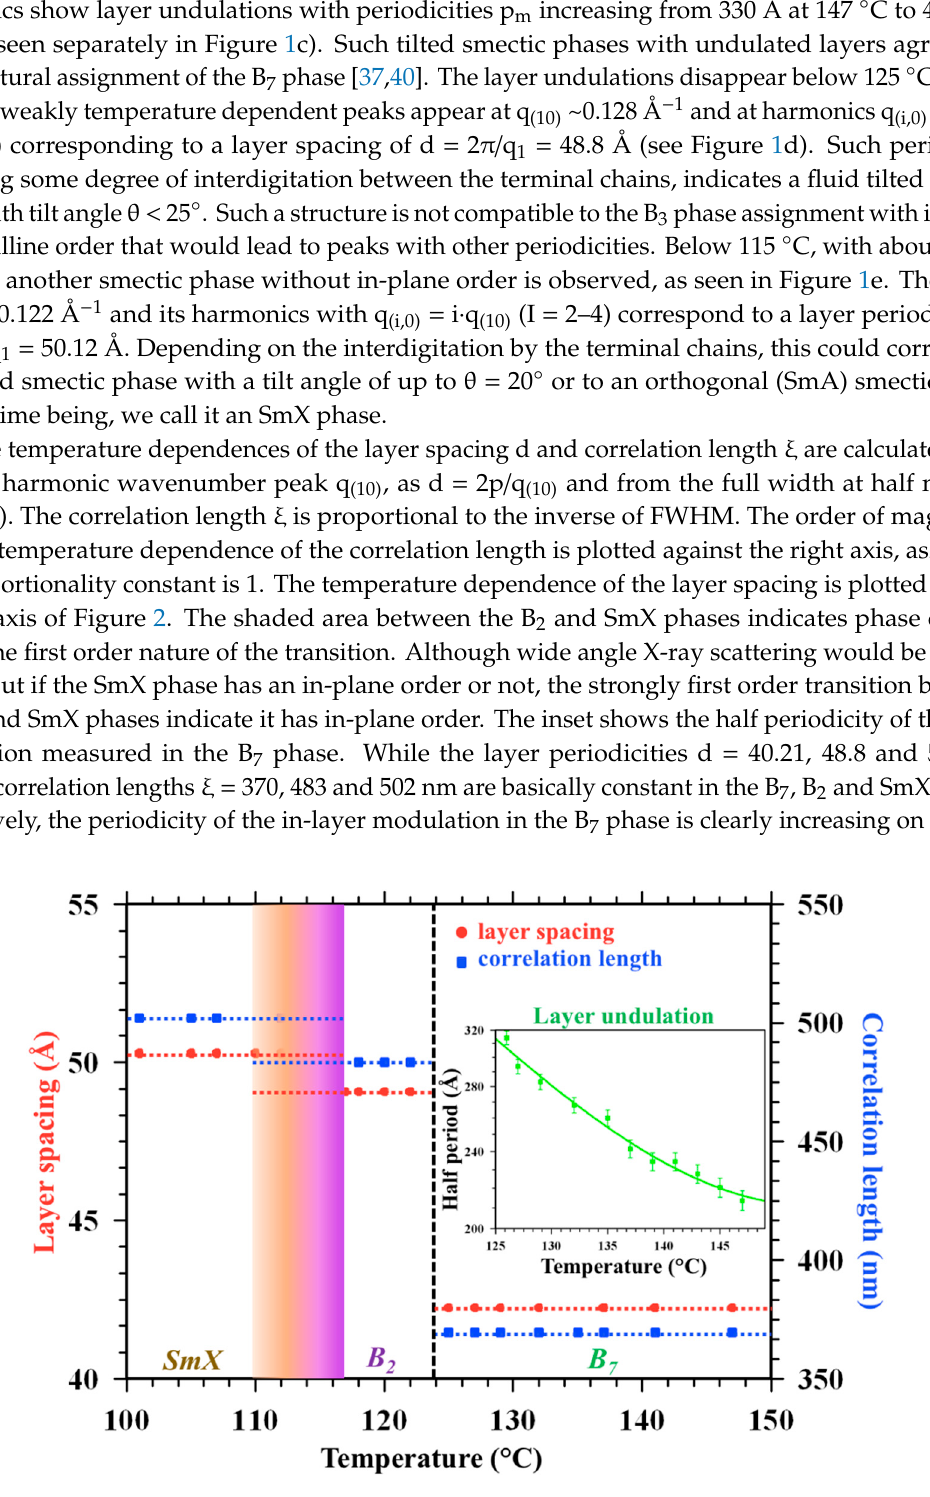
Figure 2. Temperature dependence of the layer spacing, and correlation length of B-10(S), calculated from SAXS measurements. Shaded area between the B 2 and SmX phases indicates phase overlap due to the first order nature of the transition. Inset shows the half periodicity of the layer undulation measured in the B 7 phase.